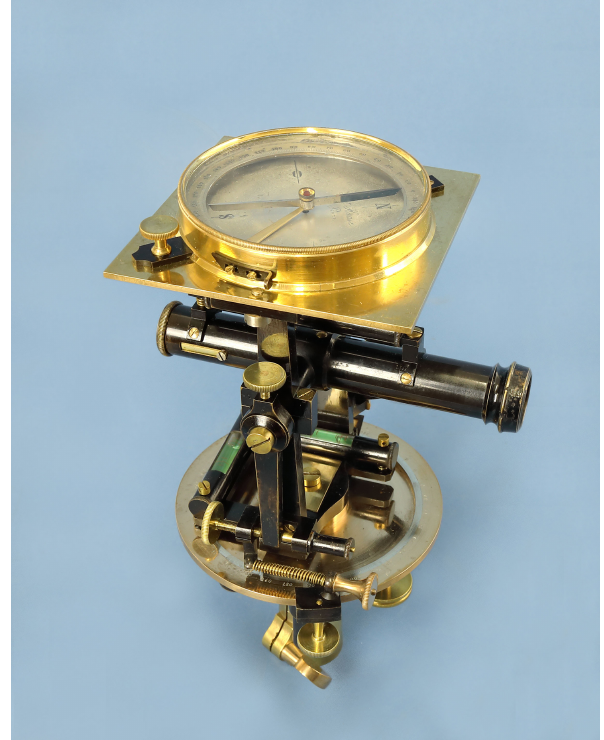
Figure 3. Tachymeter by Hasse and Wilhelm (photo supplied by